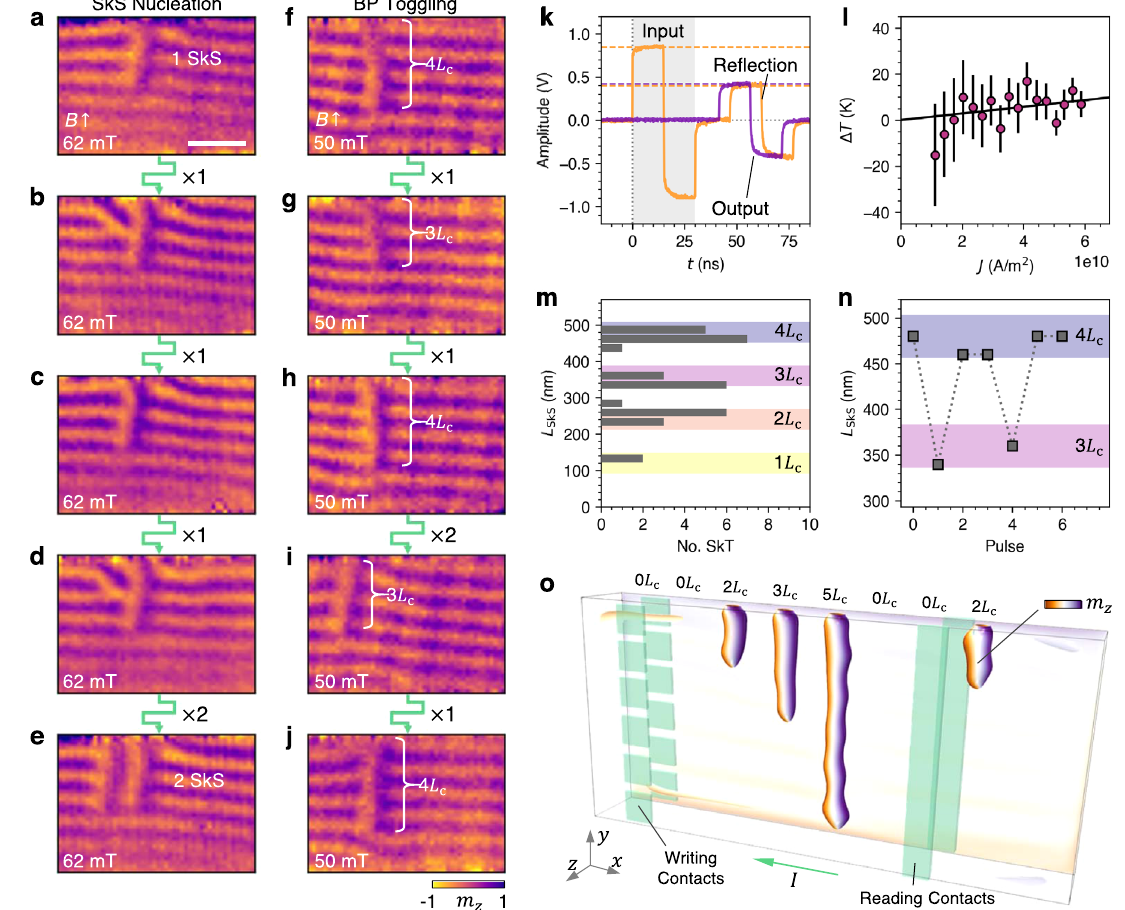
Fig. 4 Current-induced dynamics of the skyrmion string spin texture at room temperature. a – e X-ray microscopy images of the nanowire sample, showing the magnetic state following bipolar 30 ns pulses with a current density of 5.9 × 10 10 A/m 2 , showing the initial single skyrmion string (SkS) state, followed by the formation of conical dislocations and fi nally a second SkS. The number of pulses between each image is indicated. f – j Images of the nanowire sample, showing the magnetic state following bipolar 30 ns pulses of 5.9 × 10 10 A/m 2 . Successive pulses show alteration of the SkS length between 3 and 4 conical lengths L C , indicating a toggling of the Bloch point (BP) position. The colourmap indicates the out-of-plane magnetisation component, m z . The scale bar is 250 nm. k The amplitude of the bipolar pulse trace as a function of time, showing the input (orange), re fl ected (orange) and output (purple) signals. By measuring the pulse traces for a range of input amplitudes, the resistance of the sample can be calculated, and the temperature change due to Joule heating can be estimated. l The estimated change in temperature Δ T of the sample due to Joule heating as a function of current density J , suggesting a Δ T < 10 K. The error bars show the calculated standard error acquired when measuring 10 pulses at each J . m A histogram showing the measured lengths of SkSs observed within the nanowire sample. Coloured regions indicate integer values of L C , suggesting that the length of the SkS is a quantised integer of L C . n The length of the SkS in f – j after each consecutive pulse, showing the toggle-like switching of the Bloch point position located at the end of the SkS. o An illustration of an example 3D skyrmion racetrack device concept, exploiting the quantised length of the SkS as a data storage element. The colourmap indicates the out-of-plane magnetisation component, m z